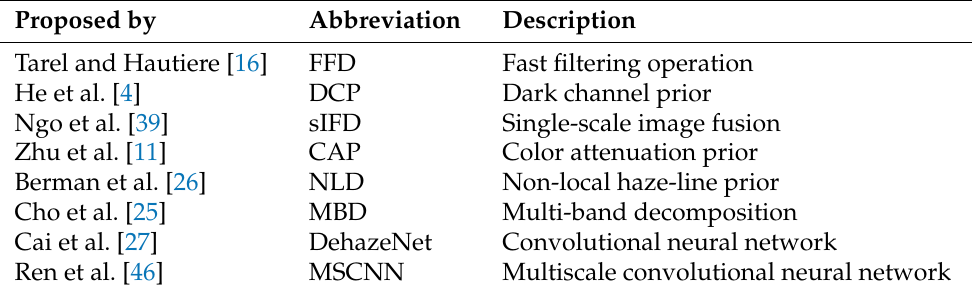
Table 2. Summary of benchmark algorithms utilized in this